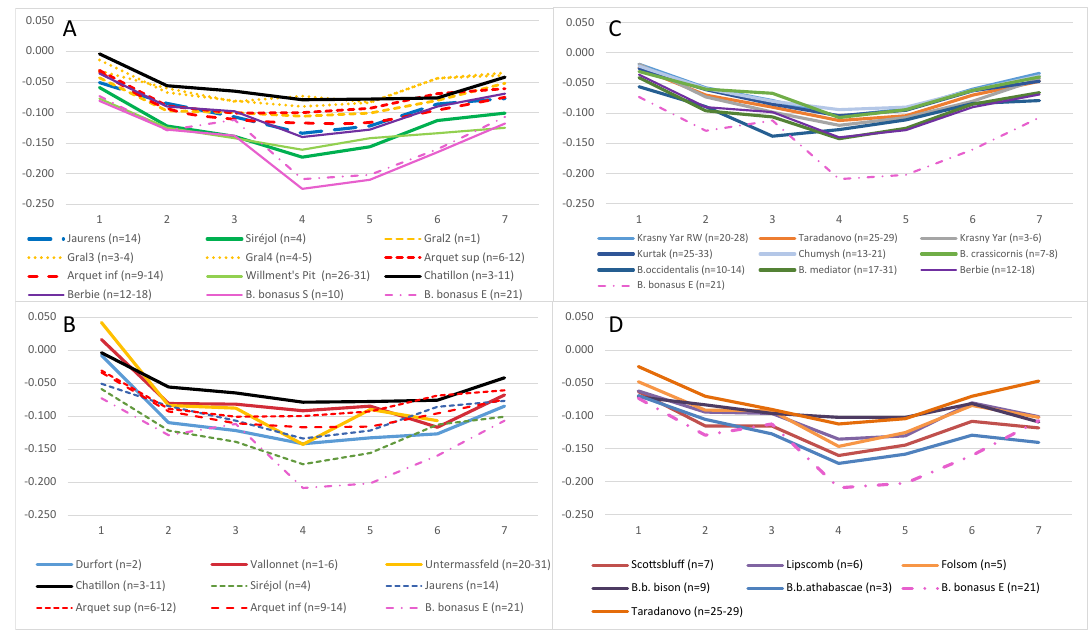
Figure 4. Comparisons of metacarpi morphology of Eurasiatic and American bison from the Pleistocene and the Holocene. ( A ) LSI comparison of Late Pleistocene European bison. The B. bonasus metacarpal measurements originating from either Schertz (1936) [21] or Empel and Roskosz (1963) [25] were distinguished (indicated by the letters S and E, respectively). Metacarpals from the Aven d’Arquet and Igue du Gral were subdivided in two groups according to the stratigraphy ( Aven d’Arquet : Inf and Sup indicate inferior and superior layers respectively; Gral4 and 2 indicate inferior and superior layers respectively). ( B ) LSI comparison of Middle and Late Pleistocene European bison. ( C ) LSI comparison of Late Pleistocene Eurasiatic bison [24]. ( D ) LSI comparison of final Pleistocene-Holocene American bison. Sample size, n, is indicated in